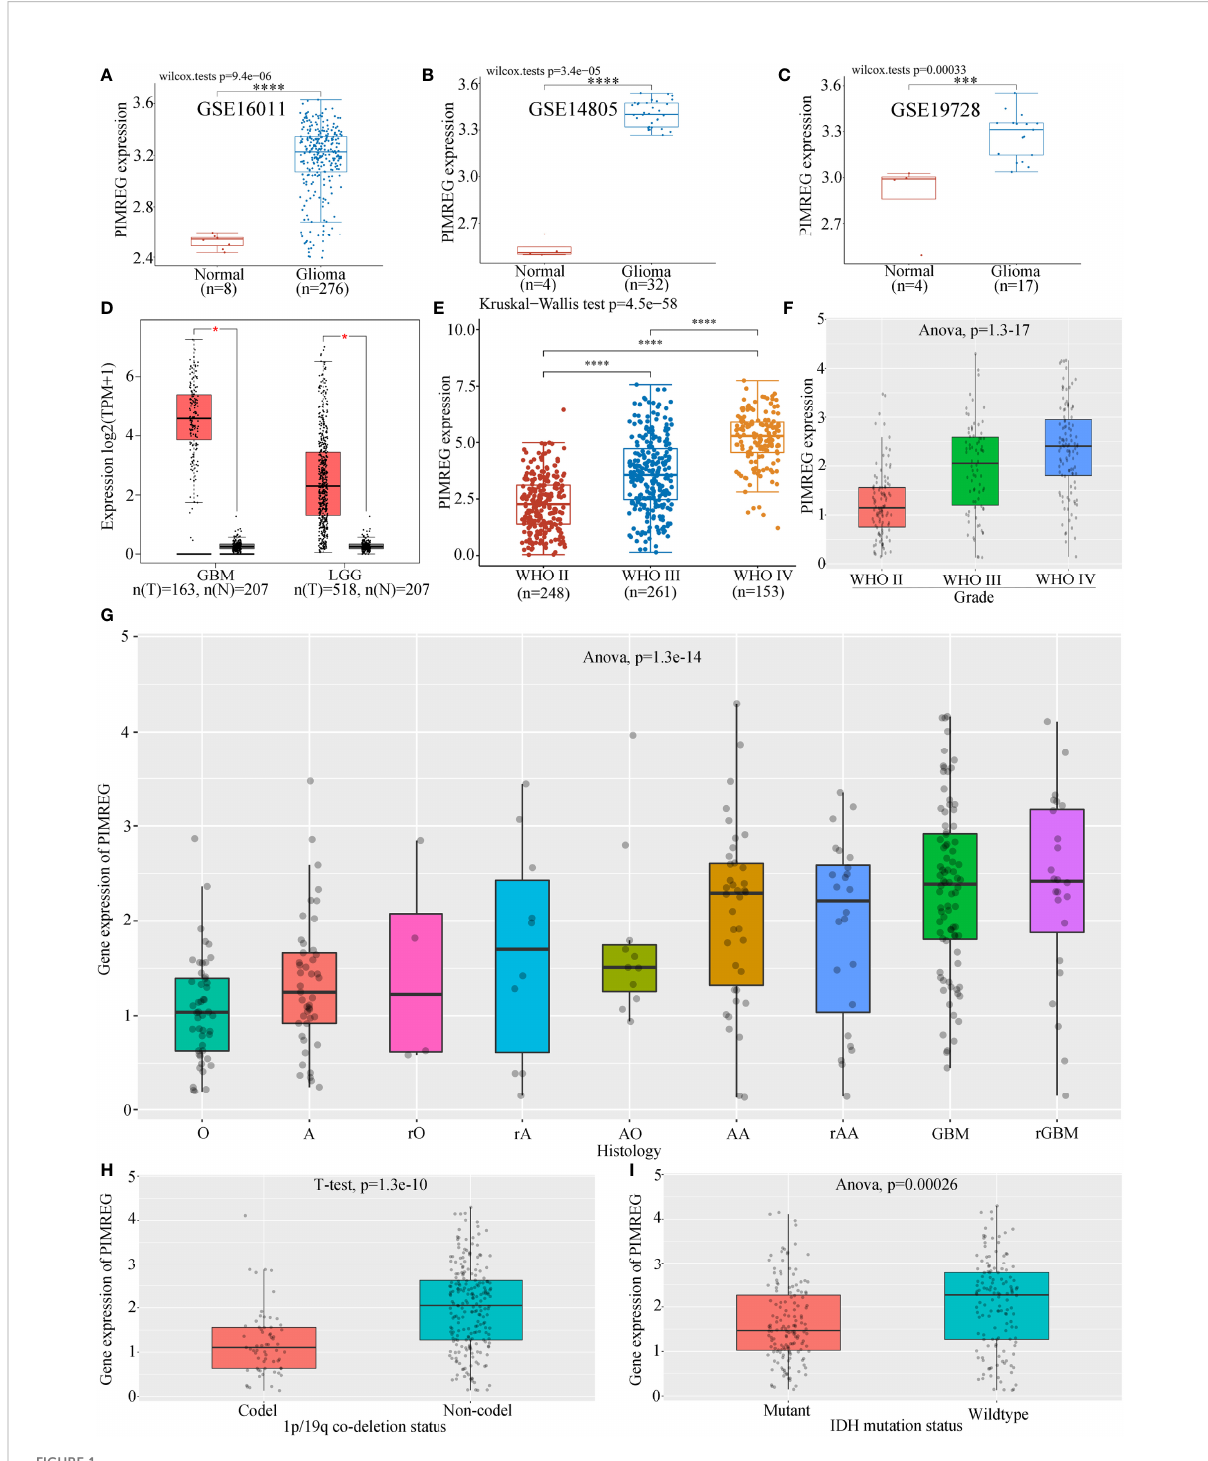
FIGURE 1 Differential expression of PIMREG in glioma and normal tissues. PIMREG expression was higher in glioma than in normal brain tissue in the GSE16011 (A) , GSE14805 (B) , and GSE19728 (C) datasets. (D) PIMREG expression was higher in both LGG and GBM than in normal brain tissue in the GEPIA 2.0 database. PIMREG expression analysis results from data downloaded from TGCA (E) and CGGA (F) . (G) Correlation between PIMREG expression in gliomas and the histology of gliomas. O: oligodendroglioma; A, astrocytoma; rO, recurrent oligodendroglioma; rA, recurrent astrocytoma; AO, anaplastic oligodendroglioma; AA, anaplastic astrocytoma; rAA, recurrent anaplastic astrocytoma; rGBM, recurrent glioblastoma. (H) PIMREG expression in gliomas with 1p/19q codeletion and non1p/19q codeletion. (I) Expression of PIMREG in IDH-mutant gliomas and wild-type gliomas. * P < 0.05; *** P < 0.001; **** P <